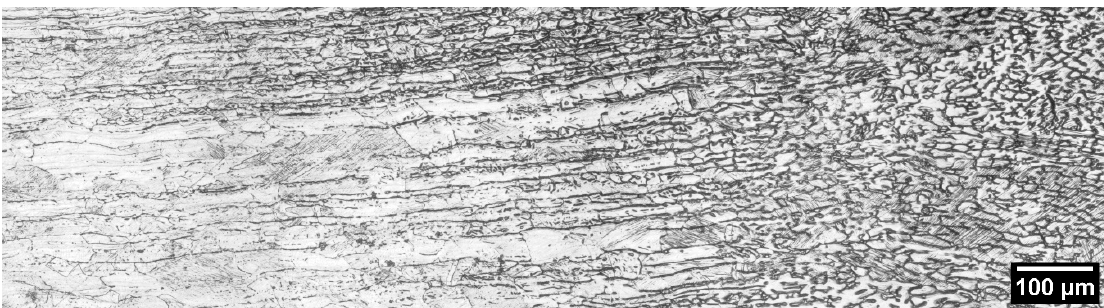
Figure 5. Transversal micrography at the weld bead (right)/HAZ (left) interface after 33% cold rolling.